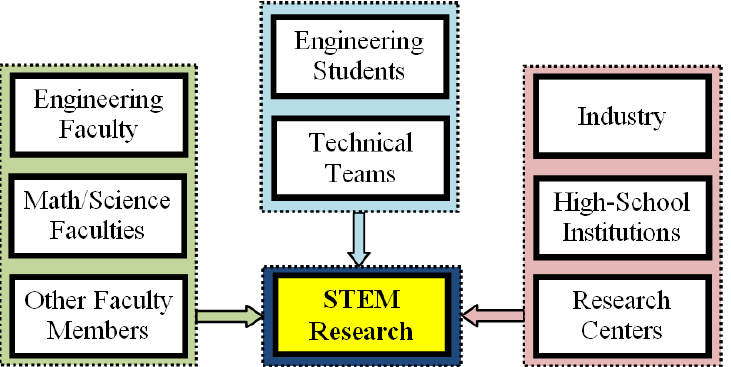
Fig. 5. Proposed structure for STEM-based research